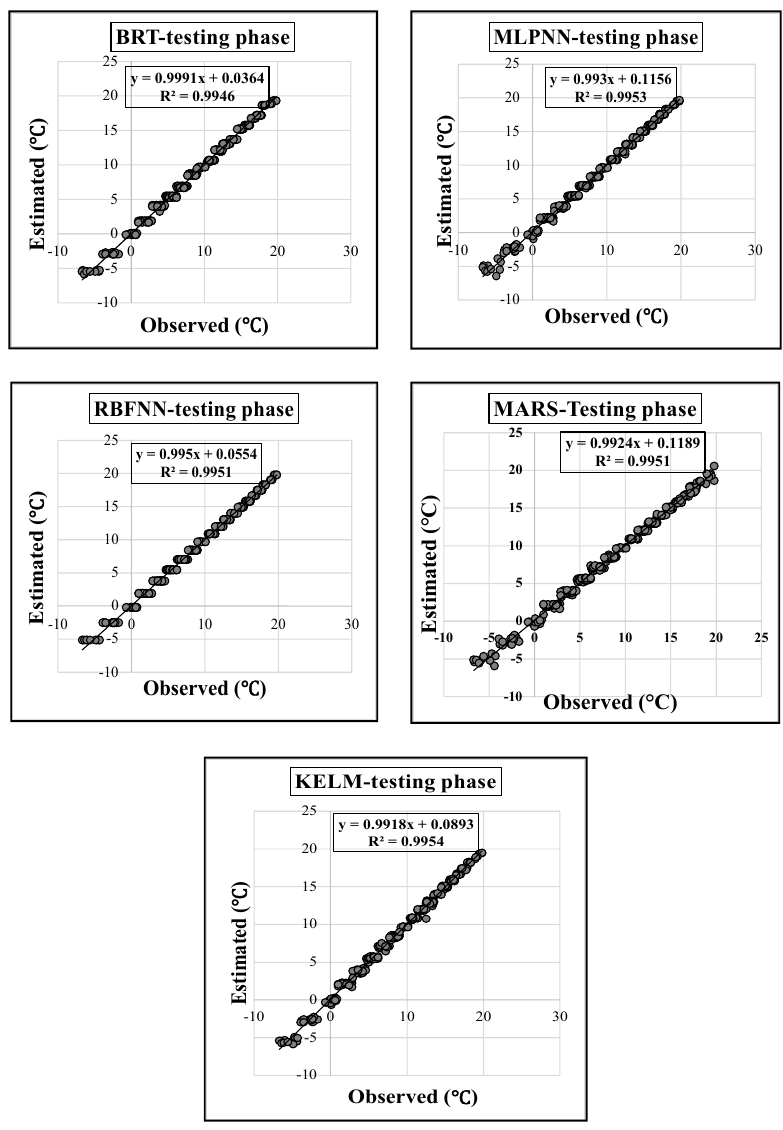
Figure 3. Comparison of observed and estimated daily T dew using the best composite models (Durham station).